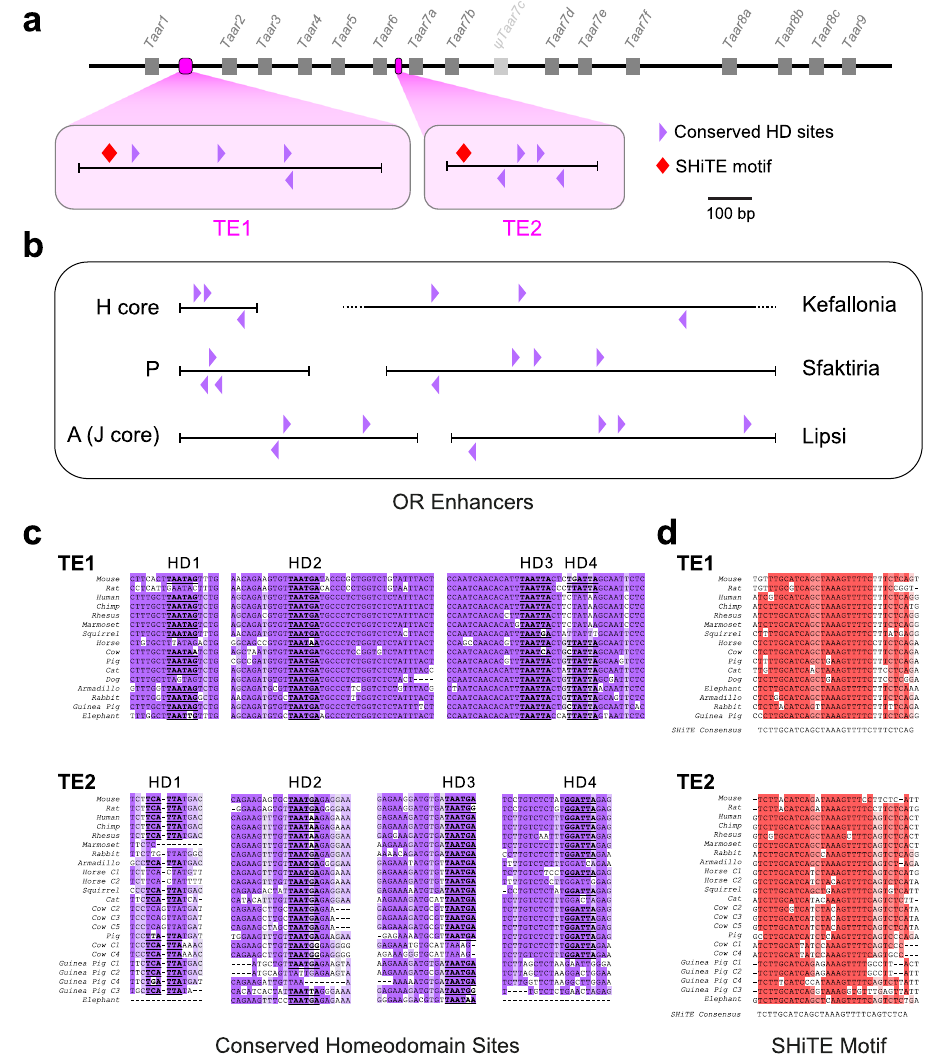
Fig. 3 The T-elements comprise conserved homeodomain binding sites and a novel shared motif. a Schematic of the TAAR cluster showing relative positions of TE1 and TE2 (magenta). Genes are indicated by gray boxes. Schematic of the T-elements (bottom) showing placement of phylogenetically conserved HD sites (purple triangles). The T-elements also contain a highly conserved, shared homology, the SHiTE motif (red diamonds). b Schematic of known functional OR enhancers showing positions of conserved HD sites. c Alignments of segments of TE1 and TE2 from 16 mammalian species showing all conserved HD sites, HD1-4 in each. d Alignment of the TE1 and TE2 shared homology (SHiTE) motifs across representative mammalian species. Single alignment is split, top (TE1) and bottom